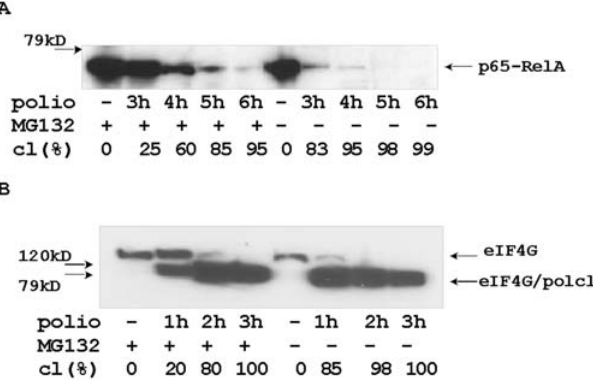
Figure 6. Proteolytic cleavage of p65-RelA and eIF4G occurred later during poliovirus infection of the cells with inhibited proteasome activity. HeLa cells and MG 132 2 h pretreated HeLa cells were infected with poliovirus (MOI=5) for 1 h. After change of medium, total protein extracts were collected every hour and tested with anti-p65-RelA C-terminus specific Abs (A) or with anti eIF4G N- terminus specific Abs (B). 10 m g of protein were tested in Western blotting